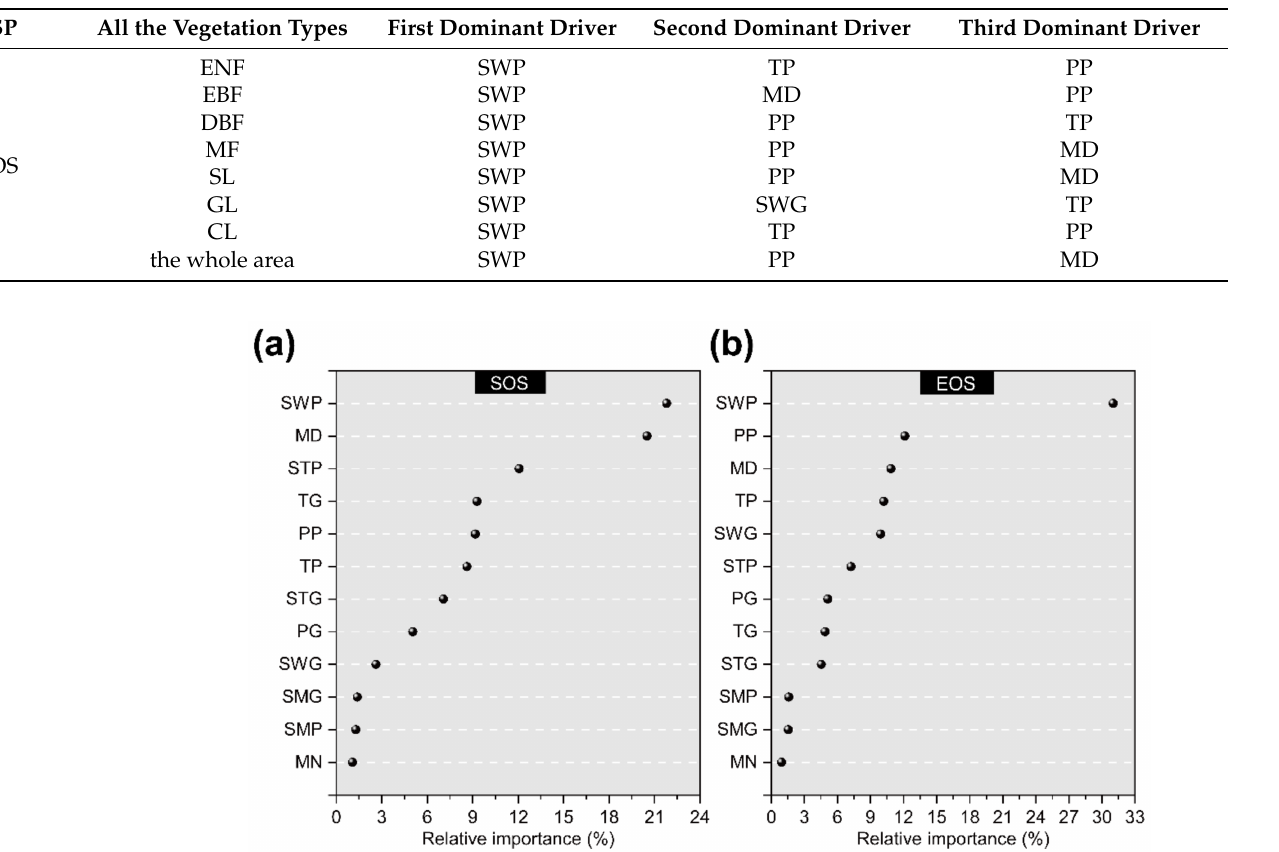
Figure 8. Relative importance of drivers of affecting interannual variations in LSP for the entire study area, in decreasing order. ( a ) The ranking of the drivers of affecting interannual variations in SOS. ( b ) The ranking of the drivers of affecting interannual variations in EOS. The specific values for the relative importance of each driver are in Table S1. Note: The abbreviated variable names are the same as in Table